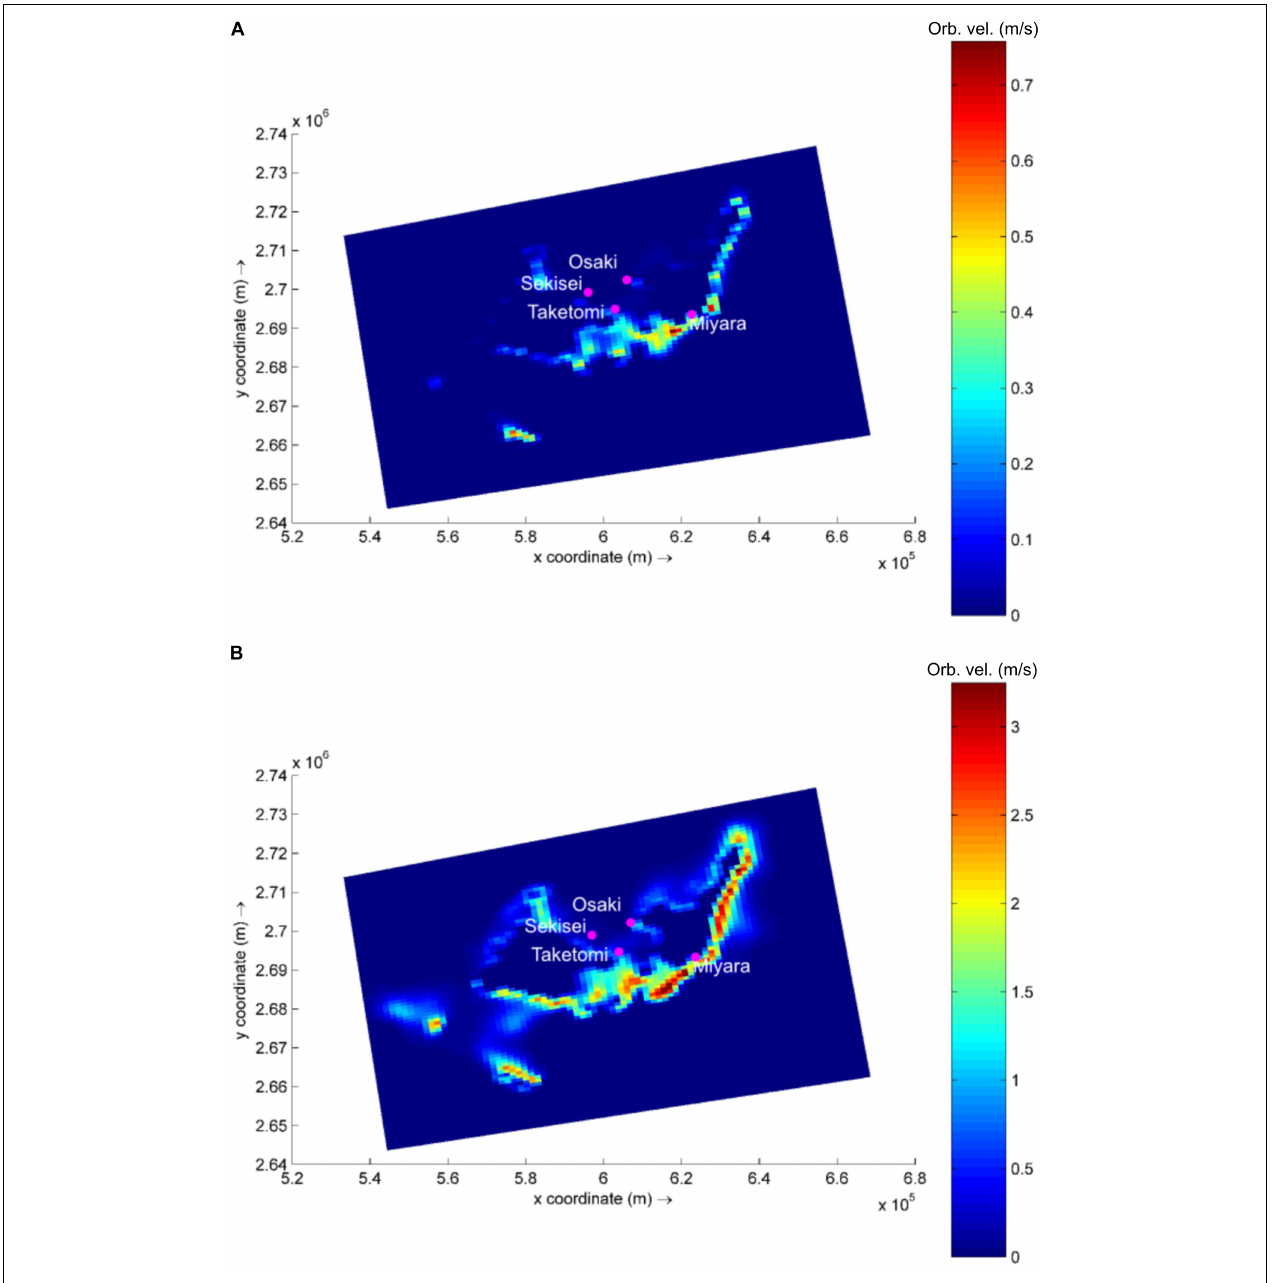
FIGURE 1 | Modeled wave generated near bottom orbital velocity (m/s) in the area of interest. Example for calm (A) and typhoon (B) wave conditions. Note difference in color bar